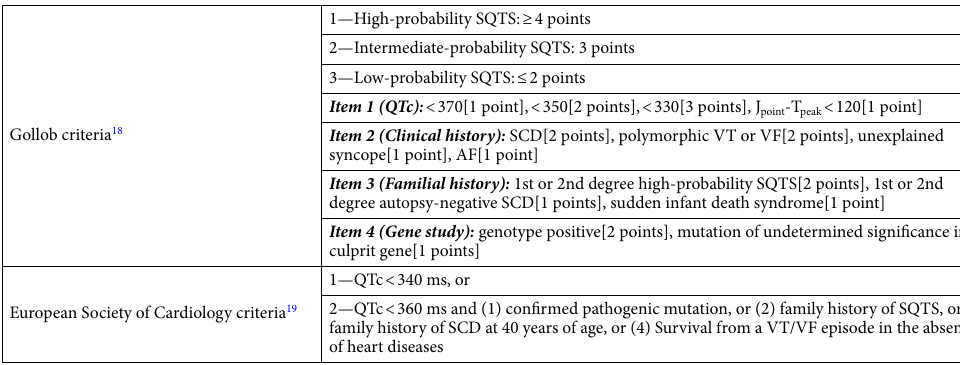
Table 1. Gollob and European Society of Cardiology criteria for diagnosing